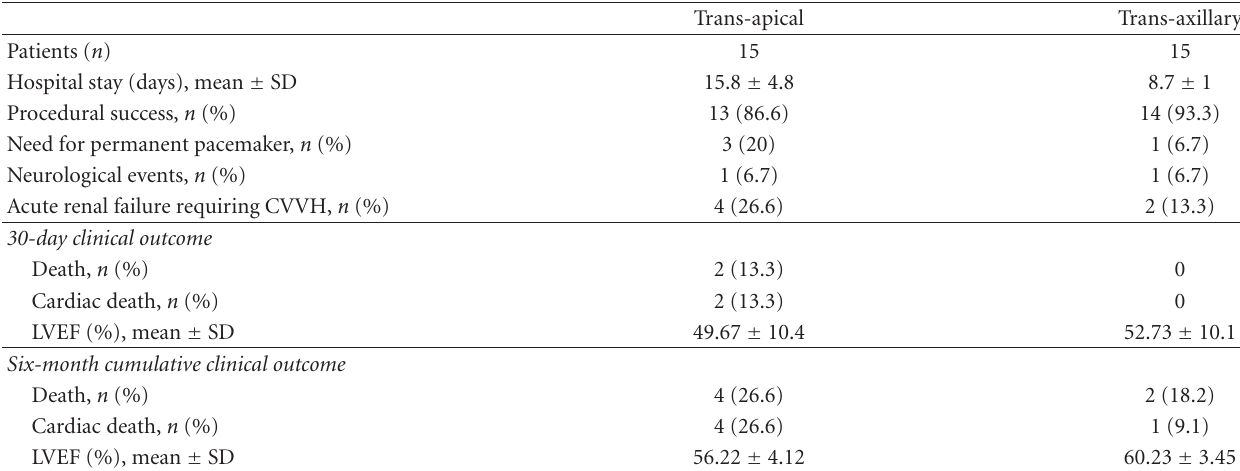
Table 3: Procedural and in-hospital results of patients submitted to trans-apical and trans-axillary TAVI Approach in our